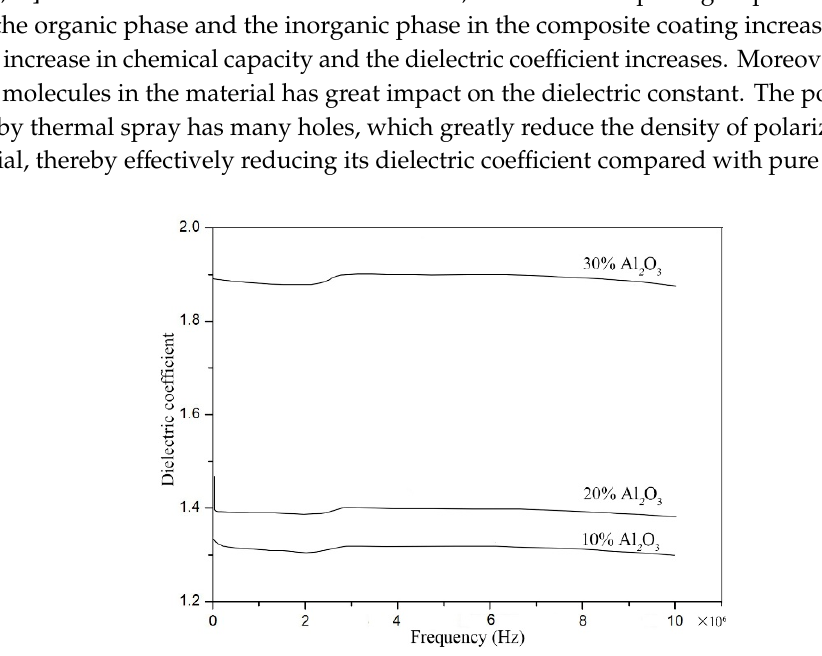
Figure 6. The dielectric coefficient polyimide/alumina composite coatings with different content of alumina.